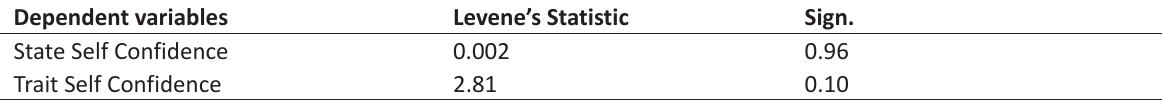
Table 4. Results of Covariance Analysis to Compare State Confidence Changes between the Study Groups Source Changes